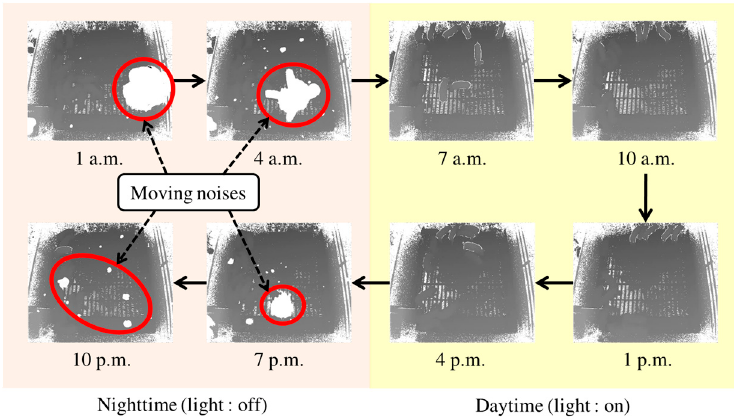
Figure 2. Daytime and nighttime images obtained from a 3D depth camera. Moving noises, shown as large white regions, can be observed at night. Table 1. Topview-based pig monitoring results (published during 2011–2017) targeted for commercial farms.